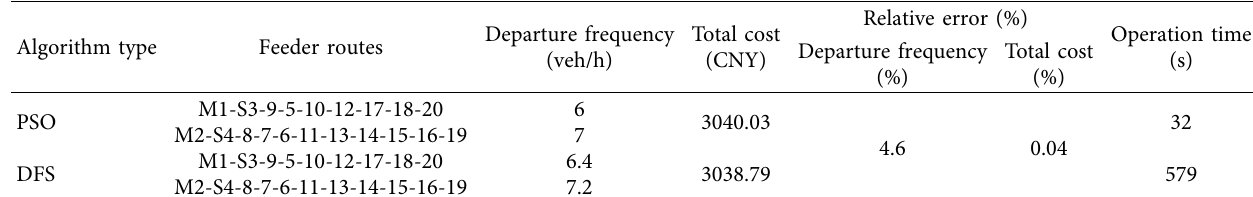
Table 8: Result of Comparative